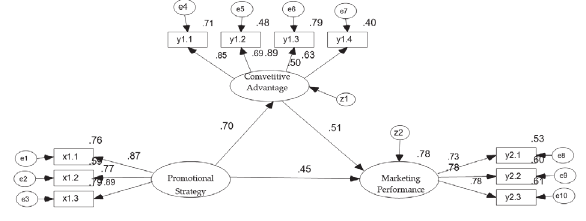
Fig. 2. The results of testing